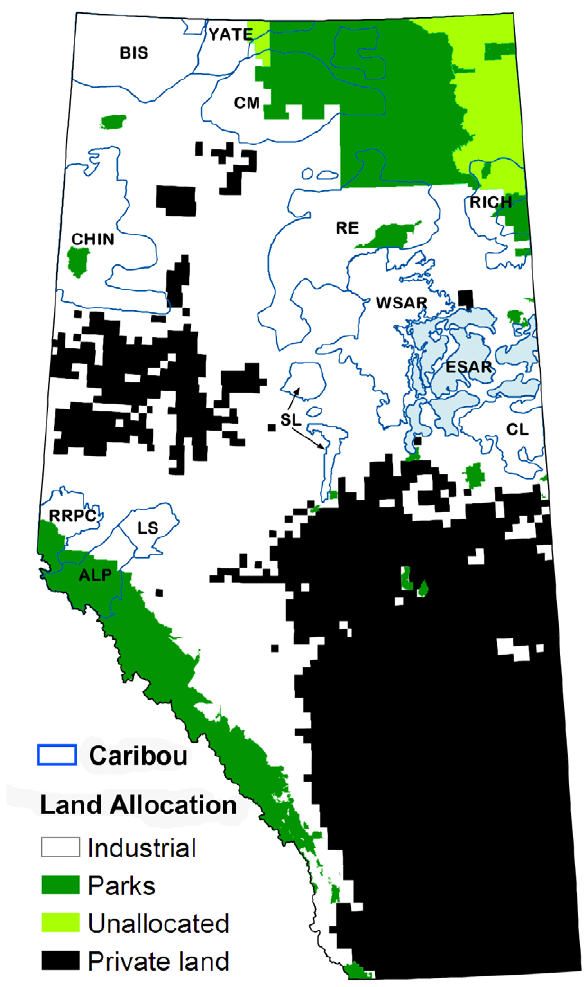
Figure 1. Study area for the Marxan modeling. Major land-use zones and the location of caribou ranges are shown. The land allocation labelled ‘‘Industrial’’ refers to oil and gas and forestry tenures on public lands. Caribou ranges are individually labelled (see Table 1) and the ESAR range is shaded for clarity.